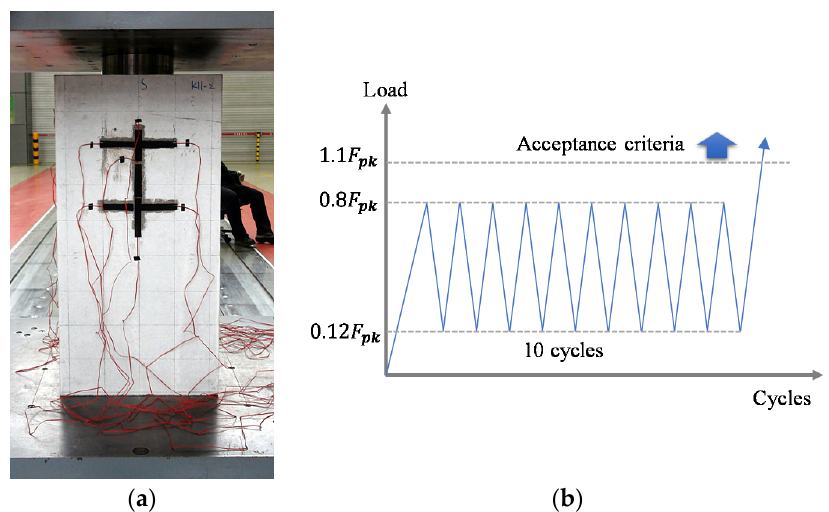
Figure 4. Test setup and loading procedure: ( a ) specimen under loading by UTM; ( b ) load-transfer test loading procedure.